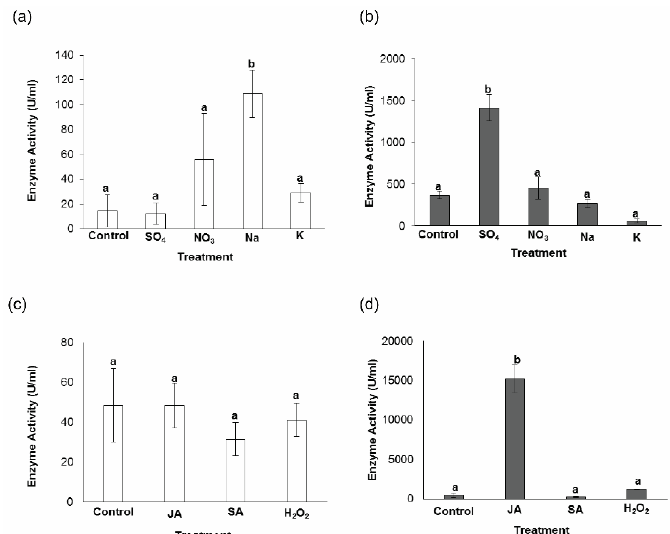
Figure 3. MnP and Lac enzyme activity in Ganoderma boninense samples in response to different nitrogen sources ( a , b ), phytohormones and hydrogen peroxide ( c , d ). ( a , c ) MnP activities; ( b , d ) Lac activities. Ammonium sulphate (SO 4 ); ammonium nitrate (NO 3 ); sodium nitrate (Na); potassium nitrate (K); jasmonic acid (JA); salicylic acid (SA) and hydrogen peroxide (H 2 O 2 ). Di ff erences between the means were analyzed using analysis of variance (ANOVA). Significant di ff erences among mean values (at p < 0.05) were estimated using Duncan’s multiple range test as indicated by di ff erent letters.